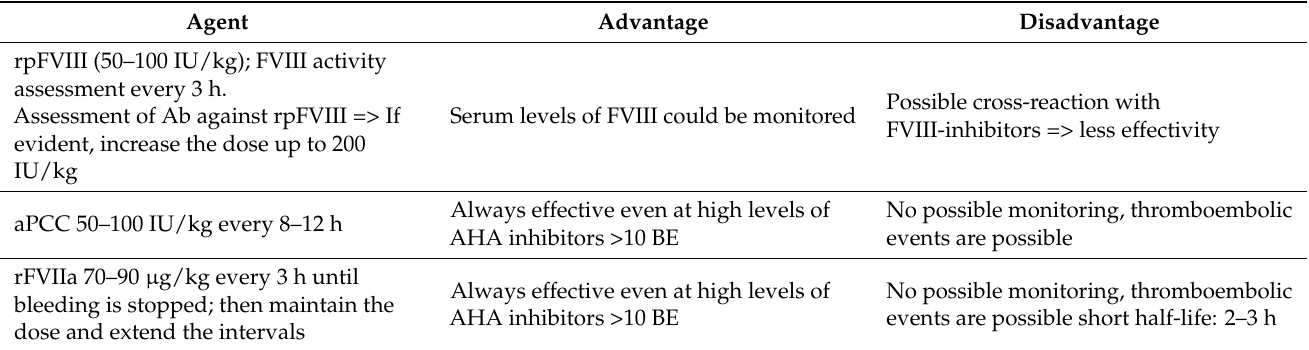
Figure 3. Acute treatment of bleeding. Modified according to Kruse-Jarres et al. [8]. Table 1. Drugs used to treat AHA-associated bleeding. Modified according to Kruse-Jarres et al. [8] .